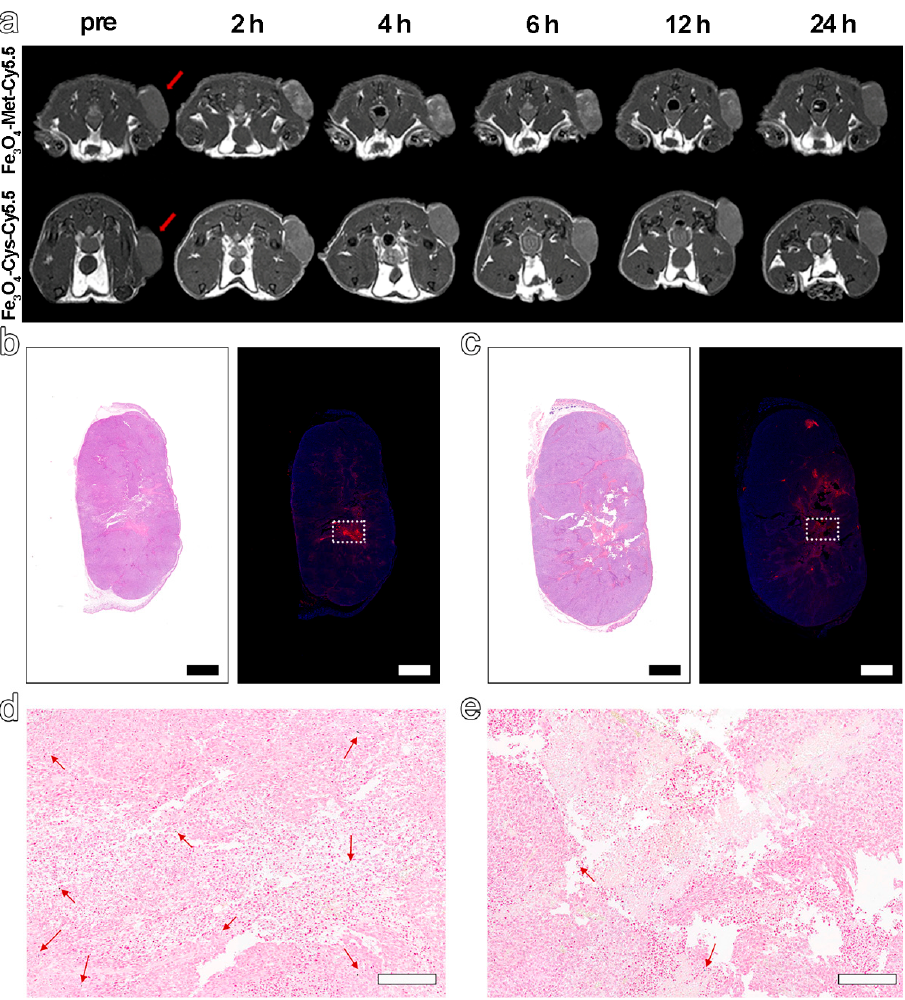
Figure 4. ( a ) T 1 -weighted MRI of tumor-bearing mice within 24 h, before and after injection with Fe 3 O 4 -Met-Cy5.5 or Fe 3 O 4 -Cys-Cy5.5. H&E staining (left) and immunofluorescence staining (right) for tumors of mice injected with Fe 3 O 4 -Met-Cy5.5 ( b ) or Fe 3 O 4 -Cys-Cy5.5 ( c ) (scale bars represent 1000 μ m). Prussian blue staining of hypoxic area (dashed area on immunofluorescence staining images) in the tumors of mice treated with Fe 3 O 4 -Met-Cy5.5 ( d ) or Fe 3 O 4 -Cys-Cy5.5 ( e ) (scale bars represent 200 μ m).